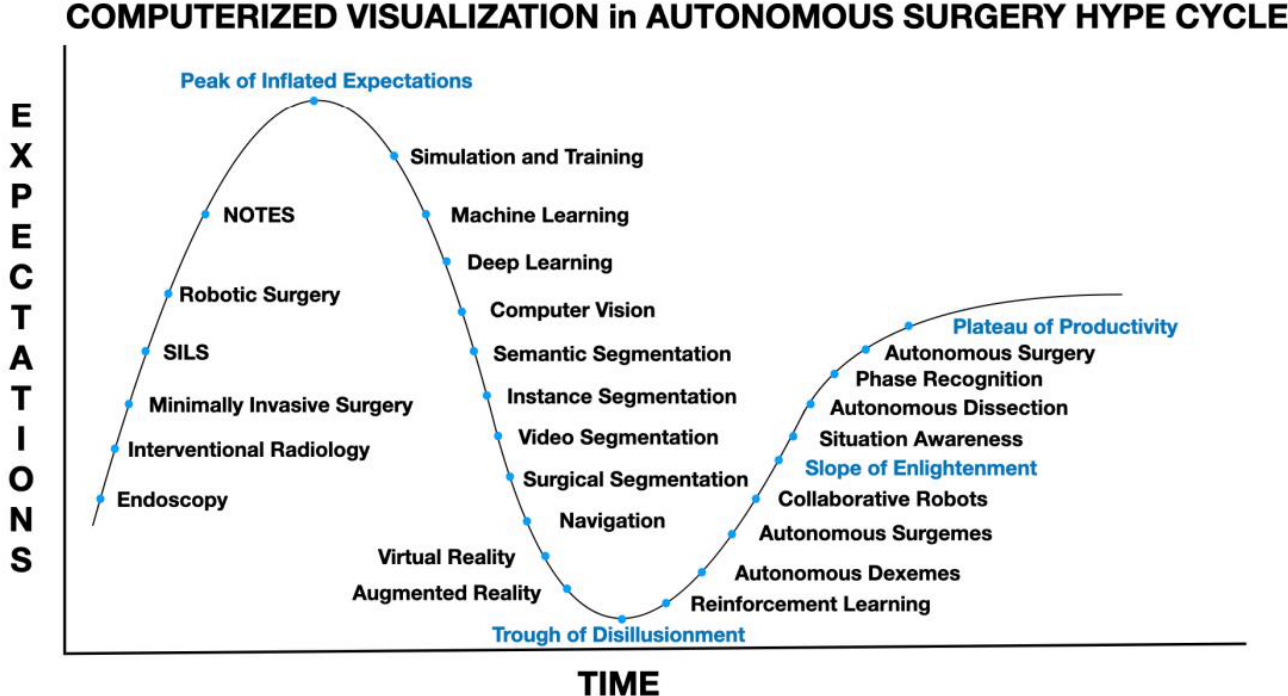
Figure 3. Computerized visualization in artificial intelligence or autonomous surgery hype cycle with potential steps necessary in-between the peak of inflated expectations, trough of disillusionment, slope of enlightenment and plateau of productivity.